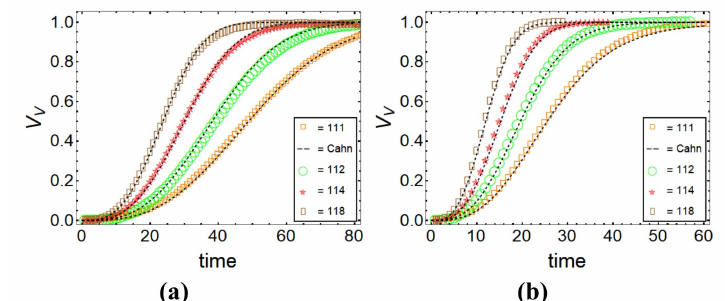
Figure 7. Effect of the aspect ratio and the number of nuclei per plane on the transformation kinetics of prolate ellipsoids. The nucleation was site-saturated. That is, all nuclei started to grow at the time origin: t 0 = . The symbols correspond to the computer-simulated result, whereas the dashed line was calculated using Cahn’s model modified for ellipsoids. On each figure, the curves show the effect of the ratio of the length of the longer axes to the shorter axis of the ellipsoids. Figure 7a depicts the transformation kinetics of prolate ellipsoids nucleated on 20 random parallel planes with 10 nuclei per each plane. Figure 7a depicts the transformation kinetics of prolate ellipsoids nucleated on 20 random parallel planes with 80 number of nuclei per plane.